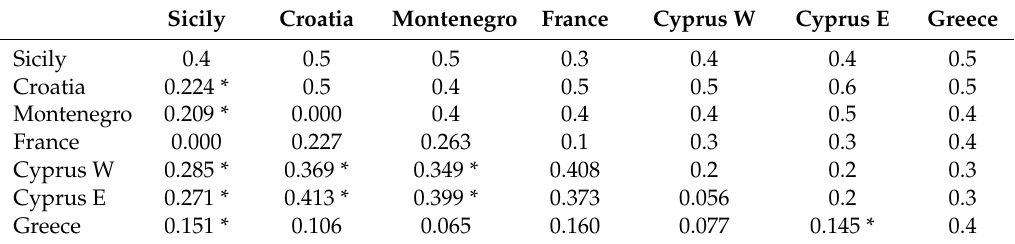
Table 3. Mean genetic distances between Gobius geniporus populations for cytochrome b (uncorrected p-distances, in %, above the diagonal), intrapopulation distances (on diagonal), and pairwise F STs (below diagonal). Significant values of F STs (at α = 0.05/number of pairs) indicated by asterisk. Sicily Croatia Montenegro France Cyprus W Cyprus E Greece Sicily 0.4 0.5 0.5 0.3 0.4 0.4 0.5 Croatia 0.224 * 0.5 0.4 0.5 0.5 0.6 0.5 Montenegro 0.209 * 0.000 0.4 0.4 0.4 0.5 0.4 France 0.000 0.227 0.263 0.1 0.3 0.3 0.4 Cyprus W 0.285 * 0.369 * 0.349 * 0.408 0.2 0.2 0.3 Cyprus E 0.271 * 0.413 * 0.399 * 0.373 0.056 0.2 0.3 Greece 0.151 * 0.106 0.065 0.160 0.077 0.145 * 0.4